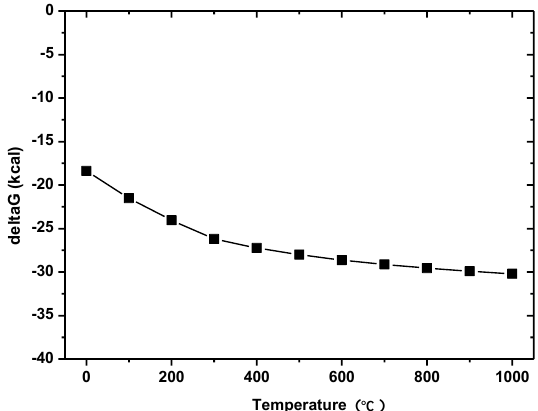
Figure 3. The Gibbs free energy change of the chemical reaction of SiO 2 (silica) and NaOH as a function of temperature. 10 Figure 4. XRD (X-ray diffraction) analysis of the residues after alkaline roasting at various temperature followed by water leaching (experimental conditions: abrasive – glass polishing waste: approximately 1 g; mass ratio of polishing waste to NaOH: 1:1; roasting time: 2 h; water leaching pH: 3; leaching temperature: 25 °C, liquid – solid ratio: 200 mL/g).